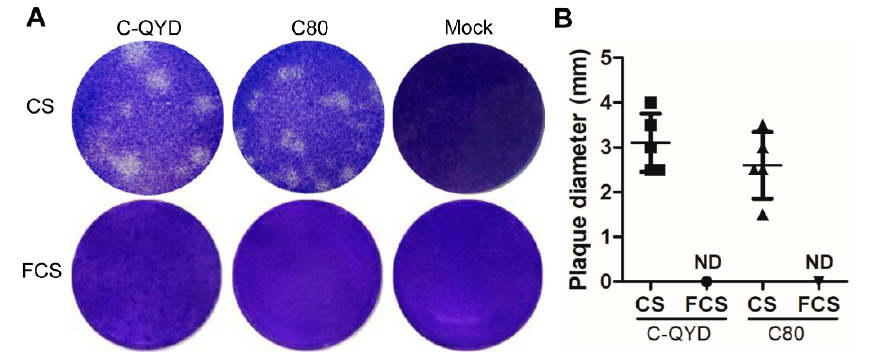
Figure 3. Effect of serum type on formation of plaques in DHAV-1-infected DEF cells. ( A ) DHAV-1 plaques in DEF cells overlaid with agarose overlays containing CS and FCS, respectively. Plaques were visualized by crystal violet staining at 60 hpi. ( B ) Comparison of the effect of CS and FCS on diameters of DHAV-1 plaques in DEF cells. ND: Not detectable.